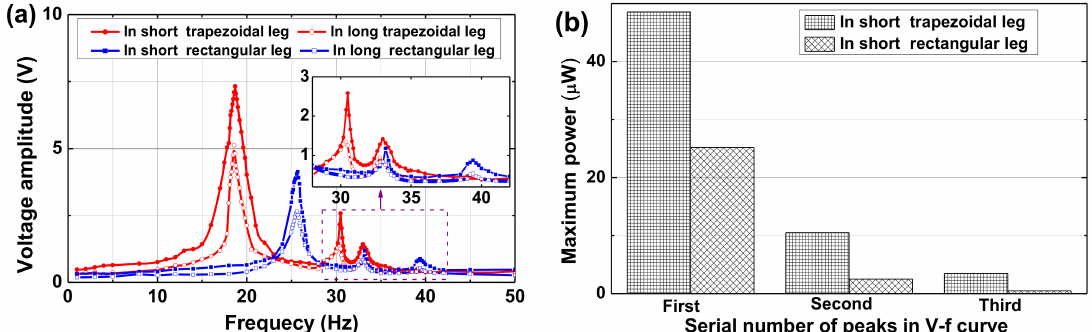
Figure 10. Experimental results for Case 2-based prototypes with the di ff erent locations for the piezoelectric plate: ( a ) voltage vs. frequency and ( b ) maximum power at the peaks of V-f